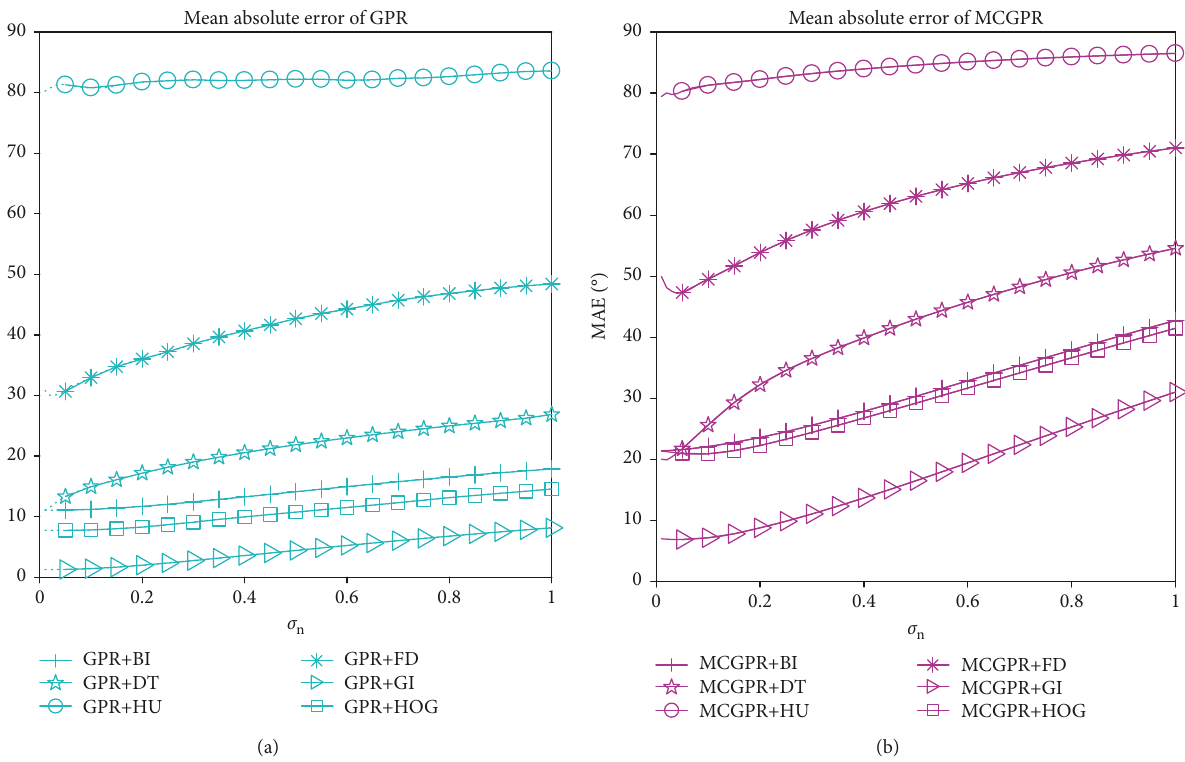
Figure 12: Cross-validation results on the 1D subset of BUAA-SID 1.5 for pose